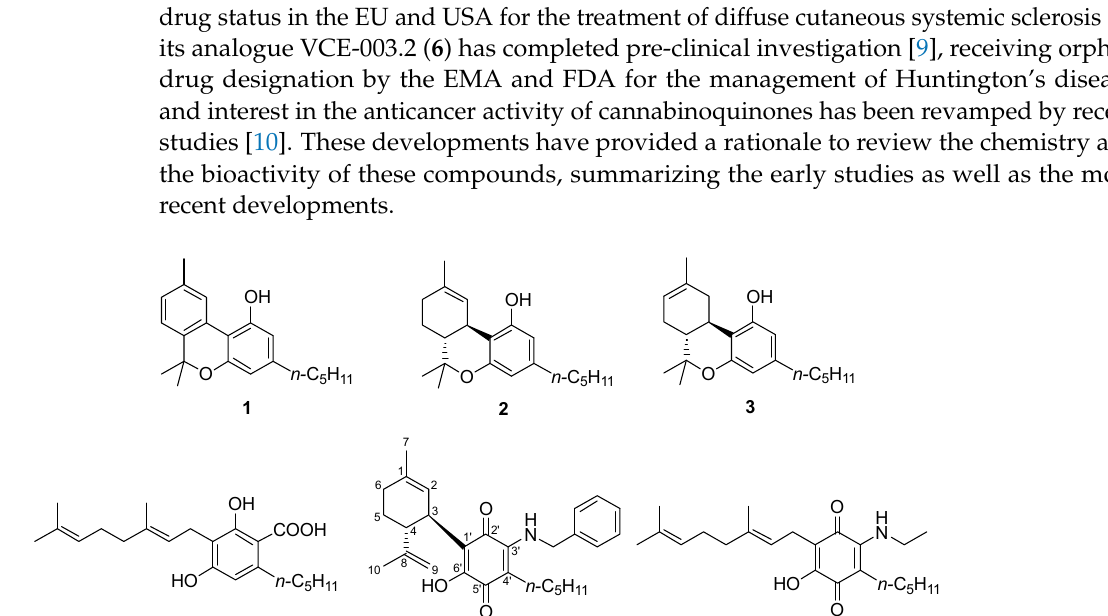
Figure 1. Structure of CBN ( 1 ), Δ 9 -THC ( 2 ), Δ 8 -THC ( 3 ), cannabigerolic acid (CBGA, 4 ), VCE-004.8 ( 5 ) and VCE 003.2 ( 6 ).